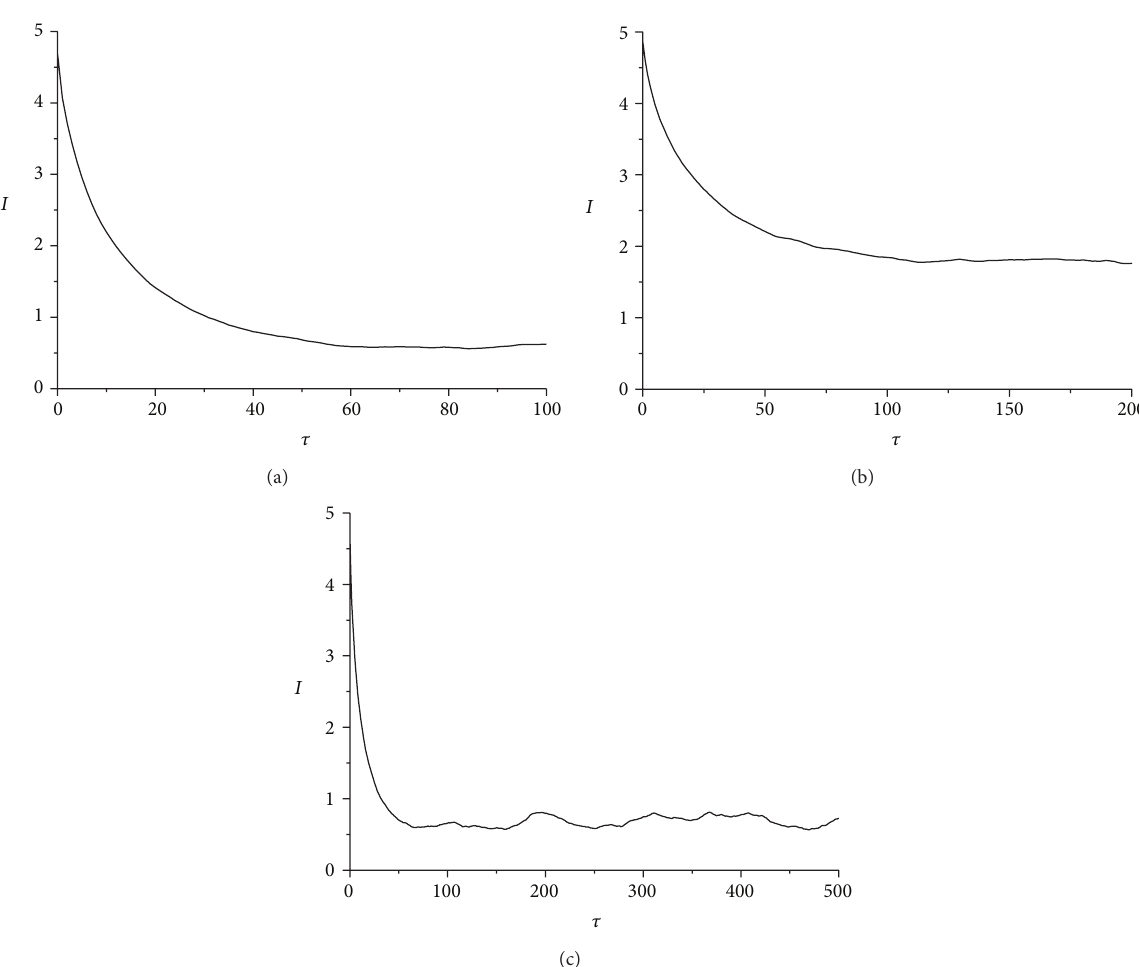
Figure 12: Average mutual information 𝐼(𝜏) versus 𝜏 time delay for angle 𝛿(𝑡) time-series in the case of (a) wax, 𝜏 = 61 , 𝑊 = 84 , (b) gypsum, 𝜏 = 114 , 𝑊 = 197 , (c) lead solder, 𝜏 = 55 , 𝑊 = 470 . It is noted that 𝜏 determines the proper delay time and 𝑊 the Theiler